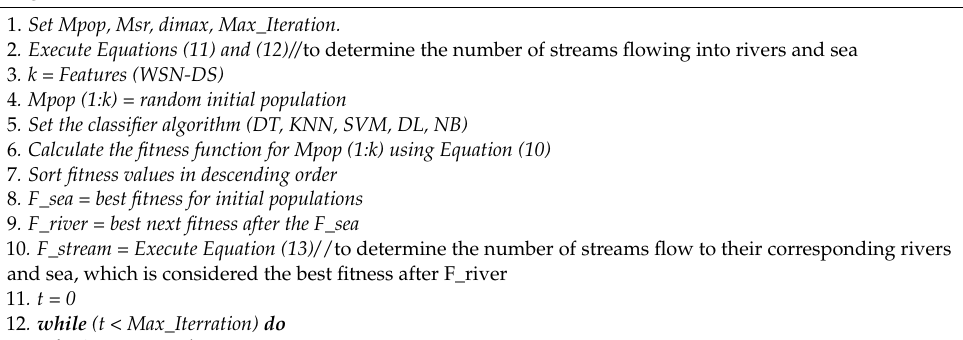
Algorithm 2 WC Feature Selection